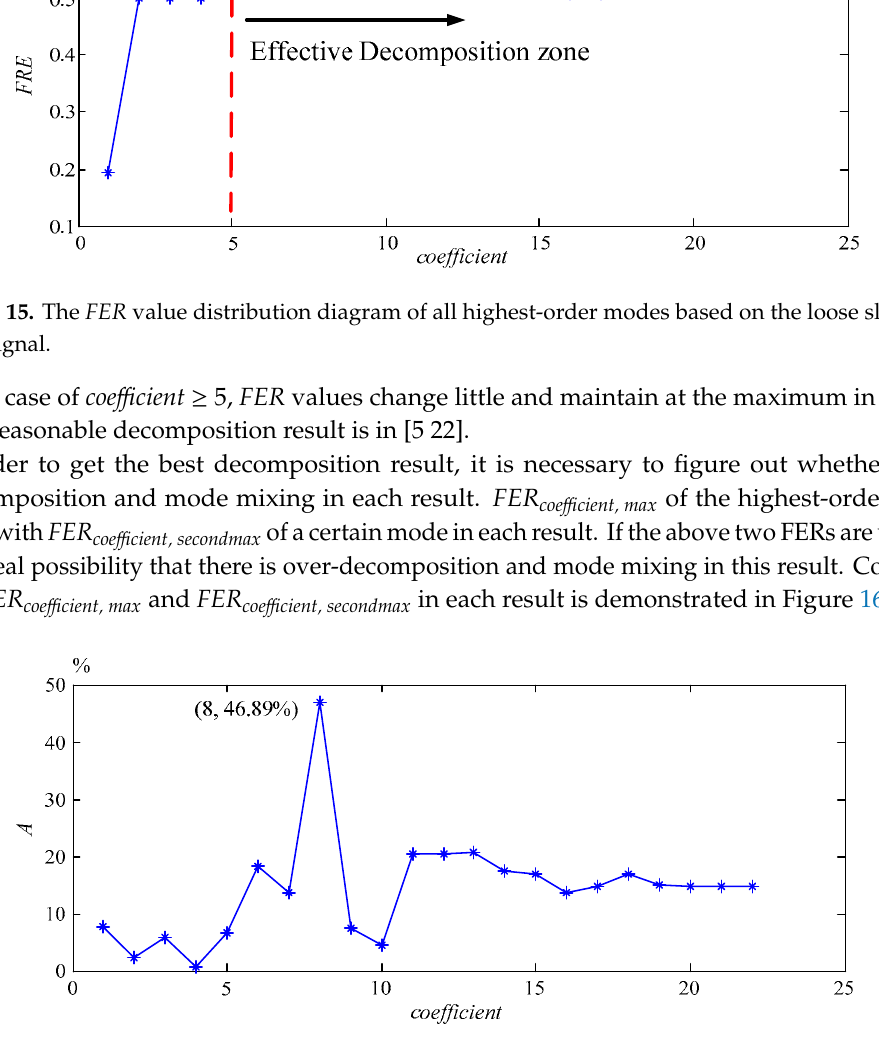
Figure 14. The distribution diagram of mode numbers based on loose slipper fault signal.